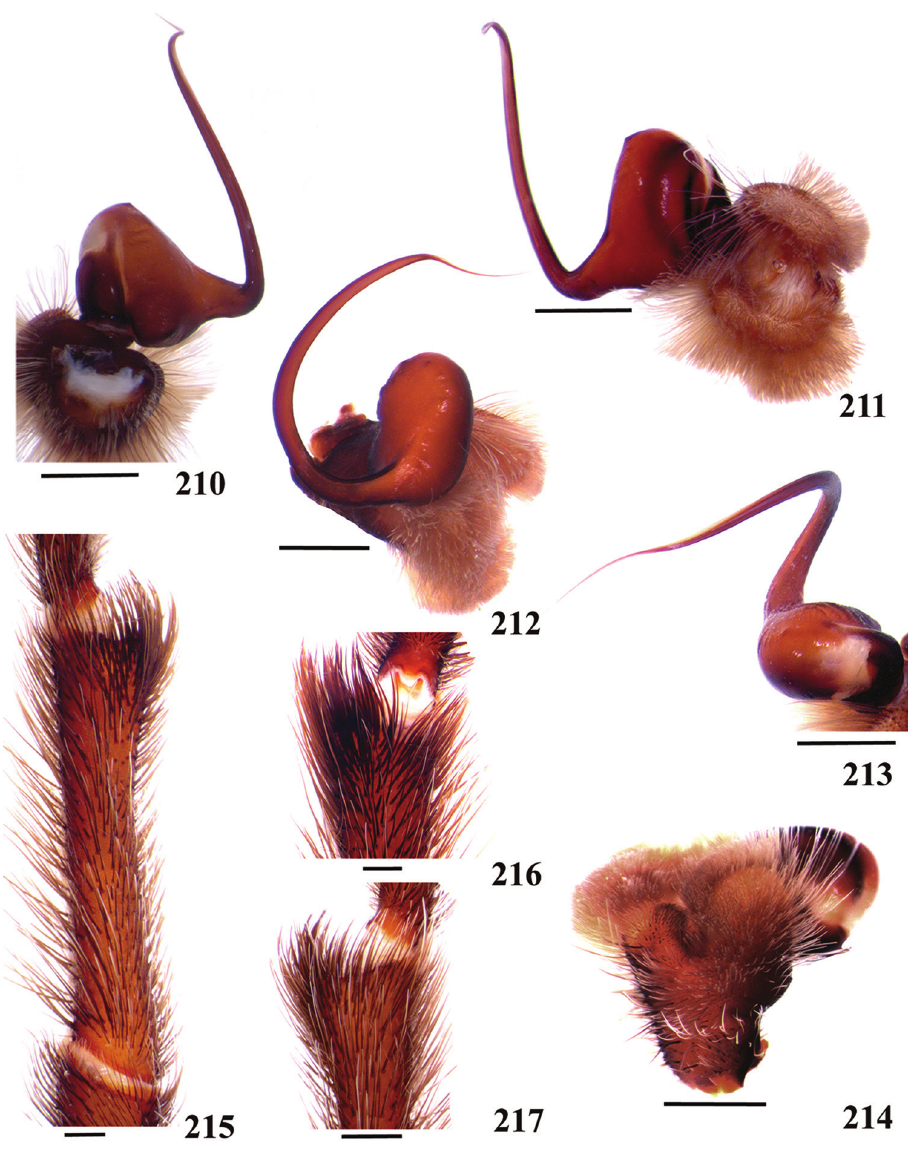
Figures 210–217. Avicularia caei sp. n., male holotype (MPEG 015637). 210–213 right palpal bulb (mirrored) 210 prolateral 211 retrolateral 212 frontal 213 dorsal 214 right cymbium, dorsal (mirrored) 215–217 right tibia I (mirrored) 215 prolateral 216 ventral 217 retrolateral. Scale bars = 1 mm. Carapace: 1.05 times longer than wide; cephalic region not raised, thoracic striae inconspicuous. Fovea: shallow, recurve, 1.14